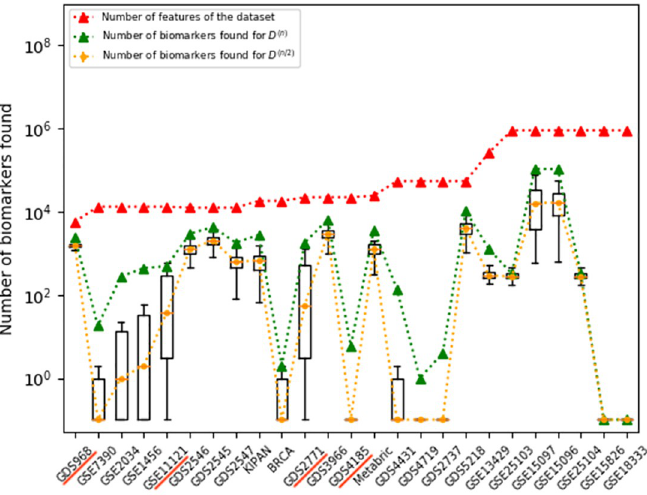
Fig 5. Number of biomarkers found for D ( n /2) compared to D ( n ) . Box+whiskers plots showing number of biomarkers found for D ( n /2) when using BD over k = 20 iterations for various dataset, compared to the number of t , 0.05, BH biomarkers for D ( n ) , and to the number of features in each dataset. Note the y-axis is a log-scale. (Note we first